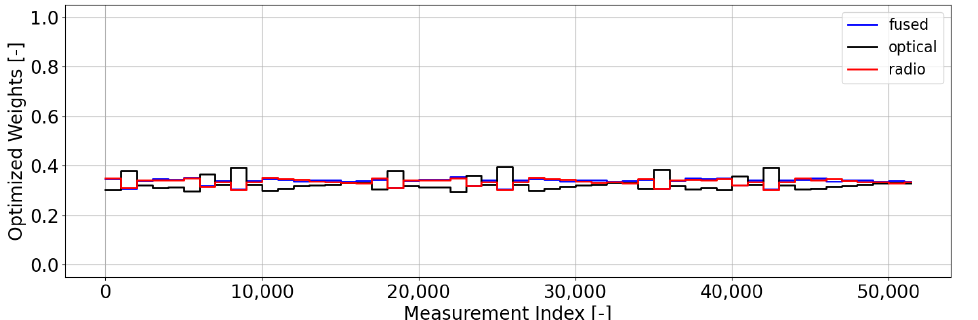
Figure 7. Optimal gating network weights with properly modeled measurements.